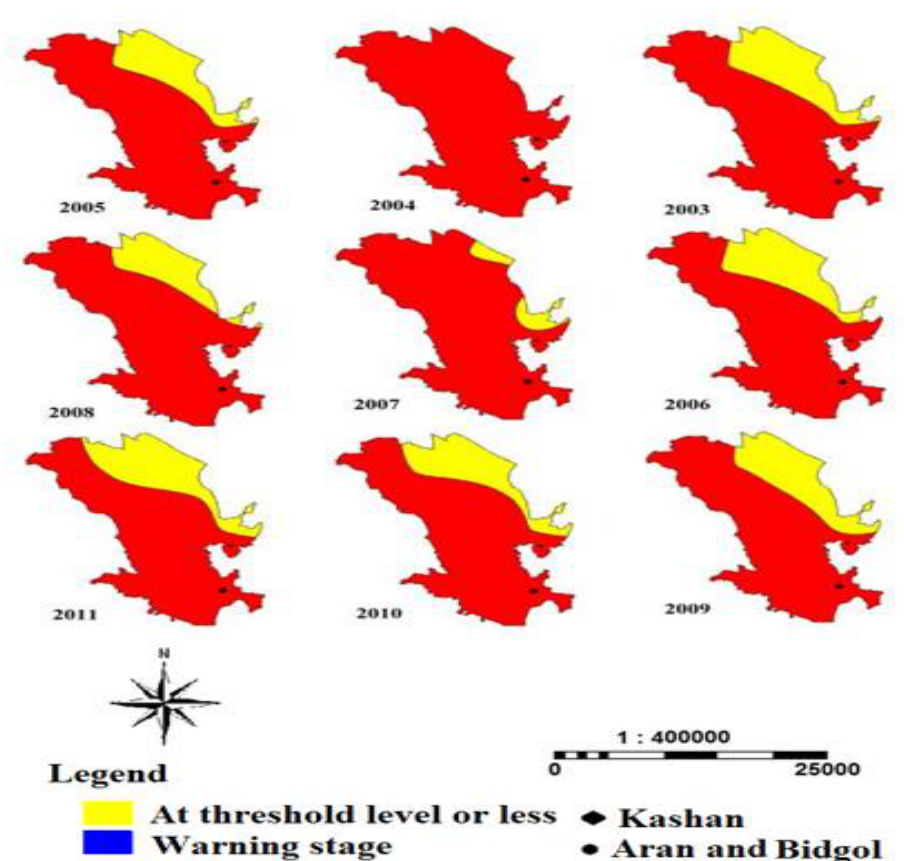
Figure 8. Map of desertification class based on SAR during